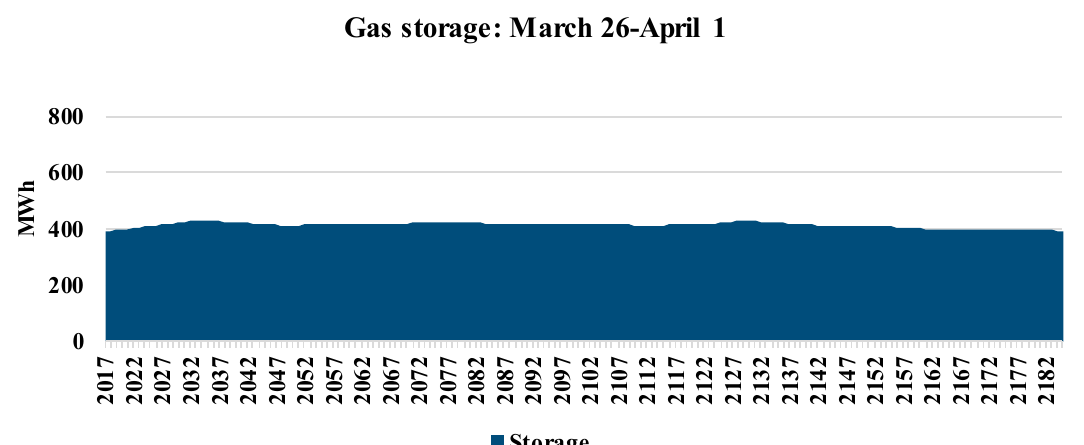
Figure 10. Gas supply ( Top ), consumption ( Centre ) and storage ( Bottom ) for the first study period: 26 March–1 April. Methanation occurs during periods of high variable RE generation and seems somewhat more associated with periods of high wind. Produced methane is stored for later use in synthetic liquid fuel production for the mobility sector only and was not needed for power or heat generation. Seasonal gas storage for these sectors was not needed in a system with high levels of V2G and thermal storage, which led to reduced system costs.